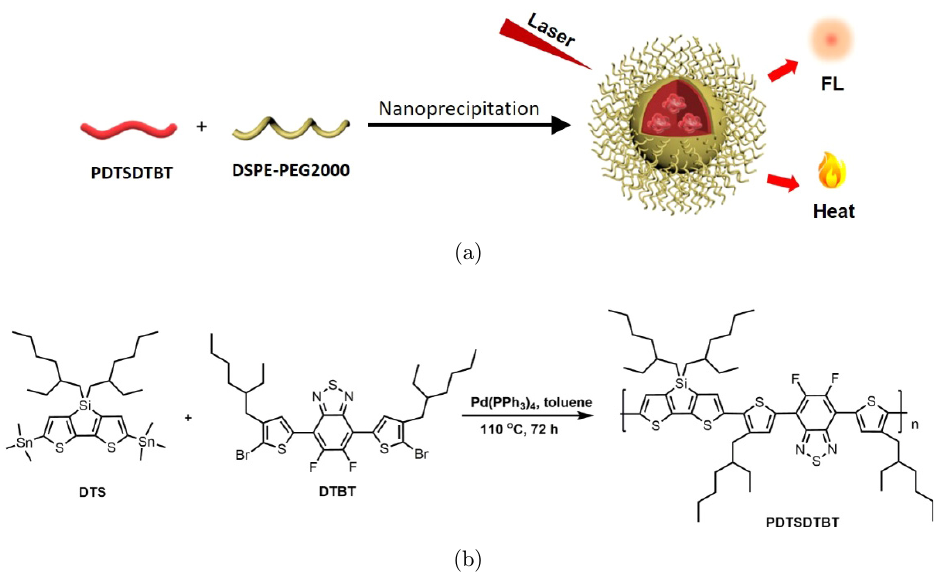
Fig. 1. (a) Schematic diagram of preparing nanoparticles by nanoprecipitation. (b) Synthetic route of